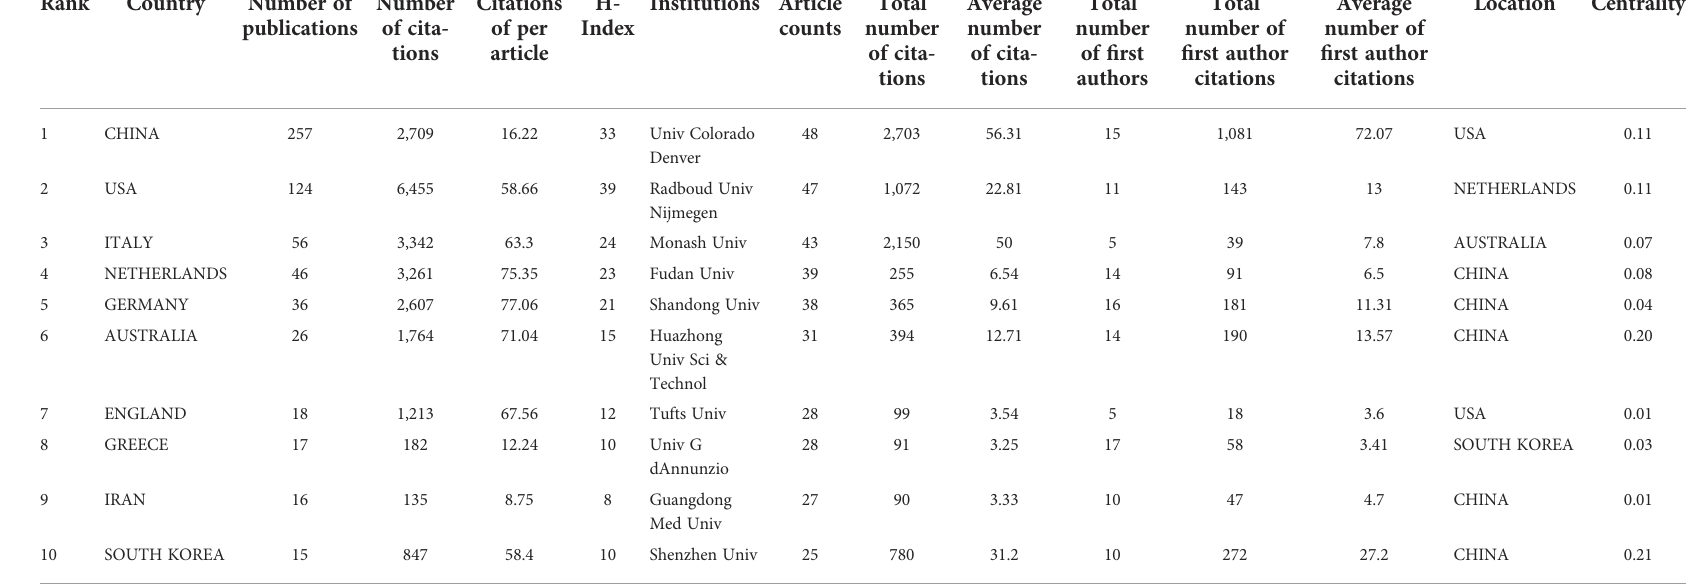
TABLE 1 The top 10 countries/regions and institutions contributing to publications of IL-37